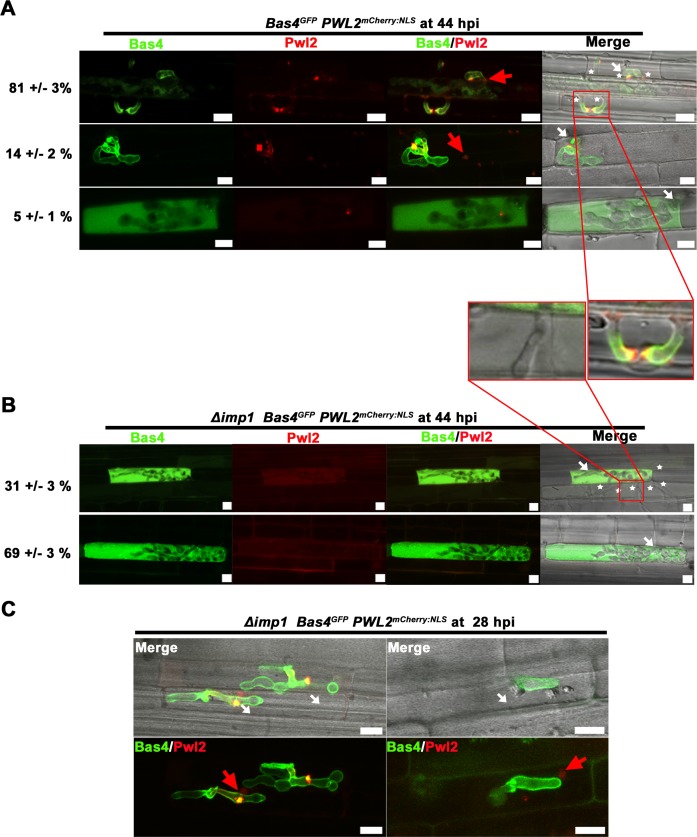
IMP1 is required for biotrophic interface longevity.WT (A) and Δimp1 (B) strains expressing the fluorescently labeled apoplastic effector Bas4GFP and the fluorescent BIC-accumulating cytoplasmic effector Pwl2mCherry:NLS at 44 hpi. Stars indicate emerging IH in adjacent cells. Arrows indicate appressoria on the leaf sheath surface. Scale bars = 10 μm. Percentages are mean values +/- s.d. of each representative image obtained from observing 100 infected rice cells per strain, repeated in triplicate. (C) Representative images of Δimp1 expressing Bas4GFP and Pwl2mCherry:NLS and infecting rice cells at 28 hpi. Small white arrows indicate appressoria on the leaf sheath surface. Large red arrow indicates accumulation of Pwl2mCherry:NLS in an adjacent rice nucleus. Scale bars = 10 μm.